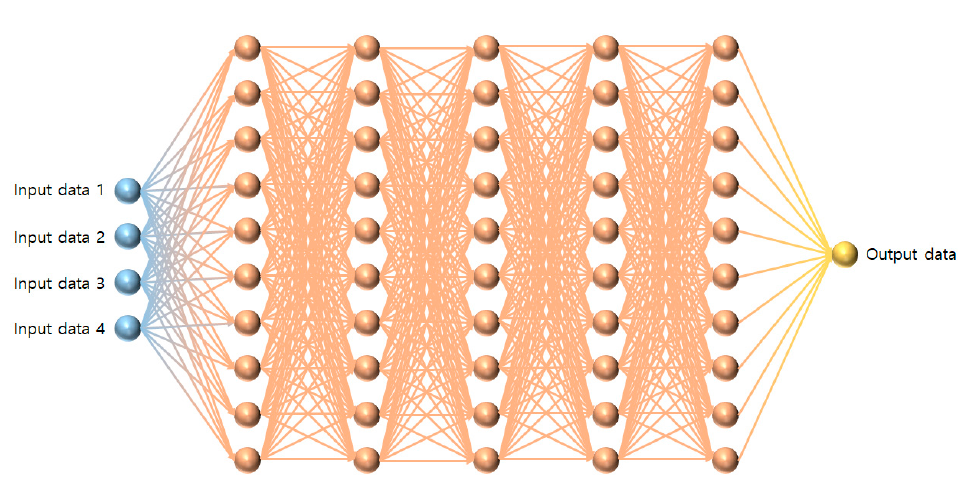
Figure 3. Structure of the MLP including MLPHS and MLPIHS used in this study.